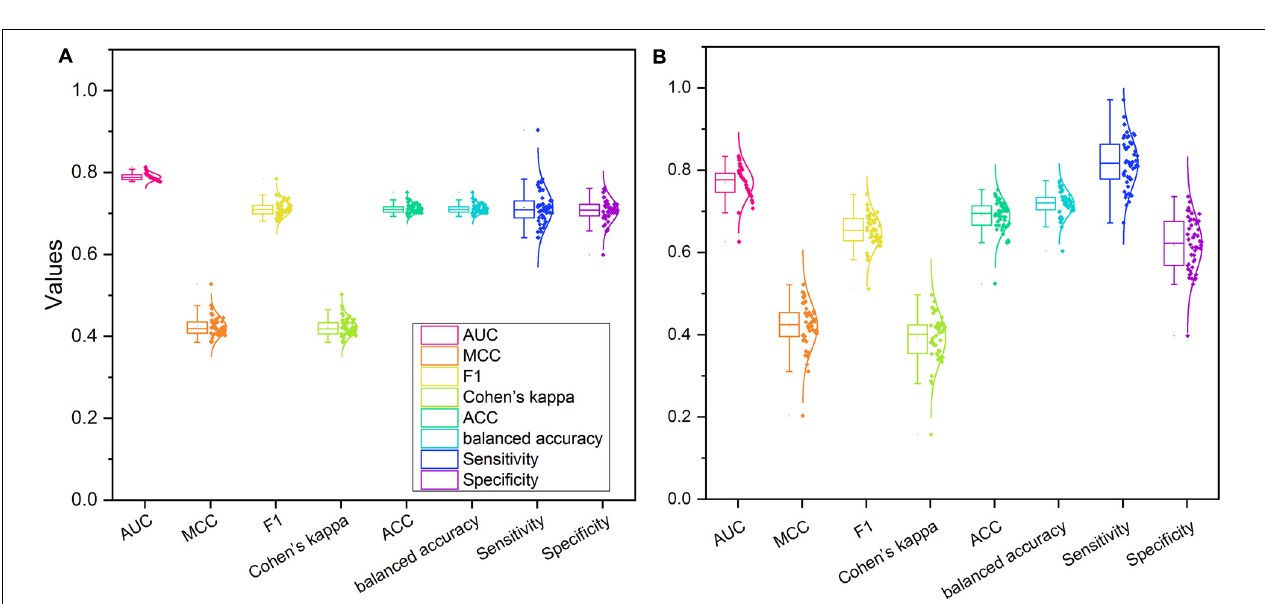
FIGURE 7 | Cytoscape network analysis of protein–protein interactions (PPIs): 482 high confidence PPIs were extracted from the STRING database version 11.0 based on 200 high-frequent genes derived from the DNN model. Panels (A,B) are the top 2 subnetworks of the PPI network obtained by using MCODE plug-in for Cytoscape. The hepatoxicity-related genes were highlighted in green color. The size of code is projected based on frequency of genes.